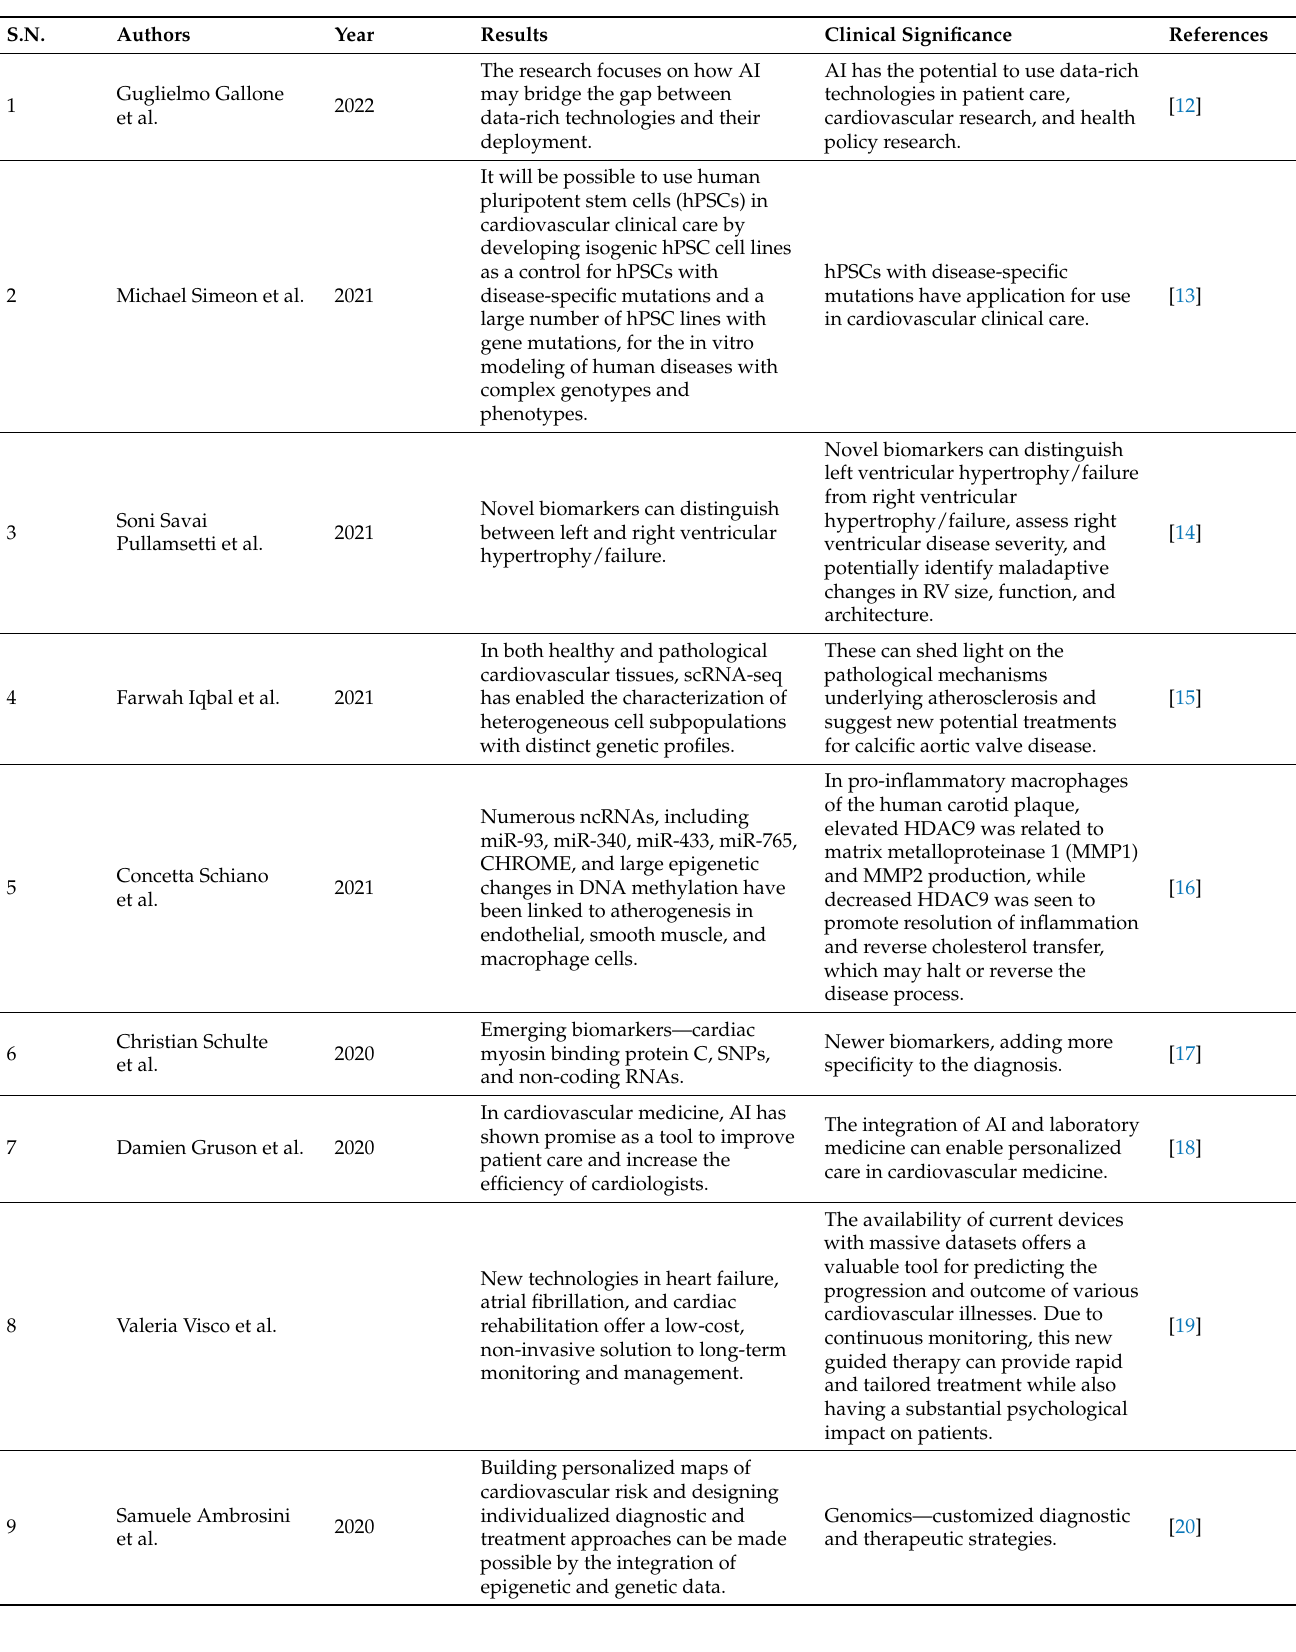
Table 1. A compilation of important reviews underlining the role of precision medicine in